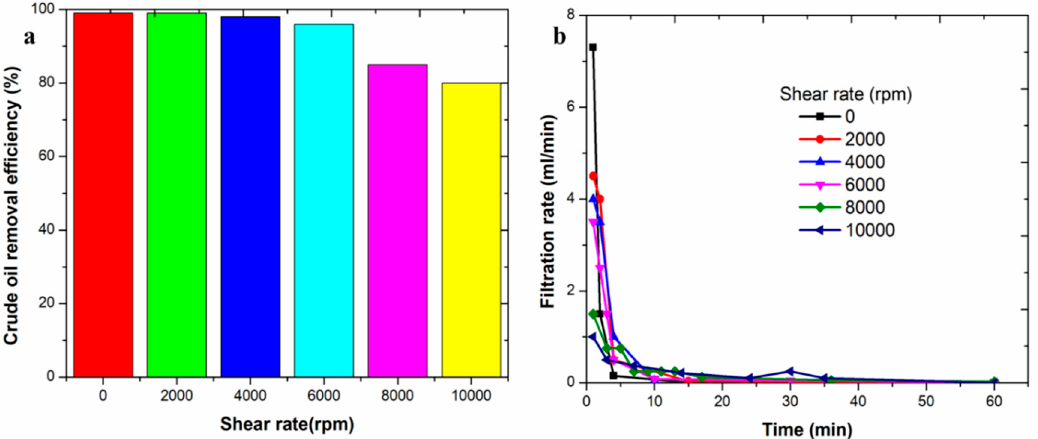
Table 2. Effect of shear rate on the liquid viscosity.